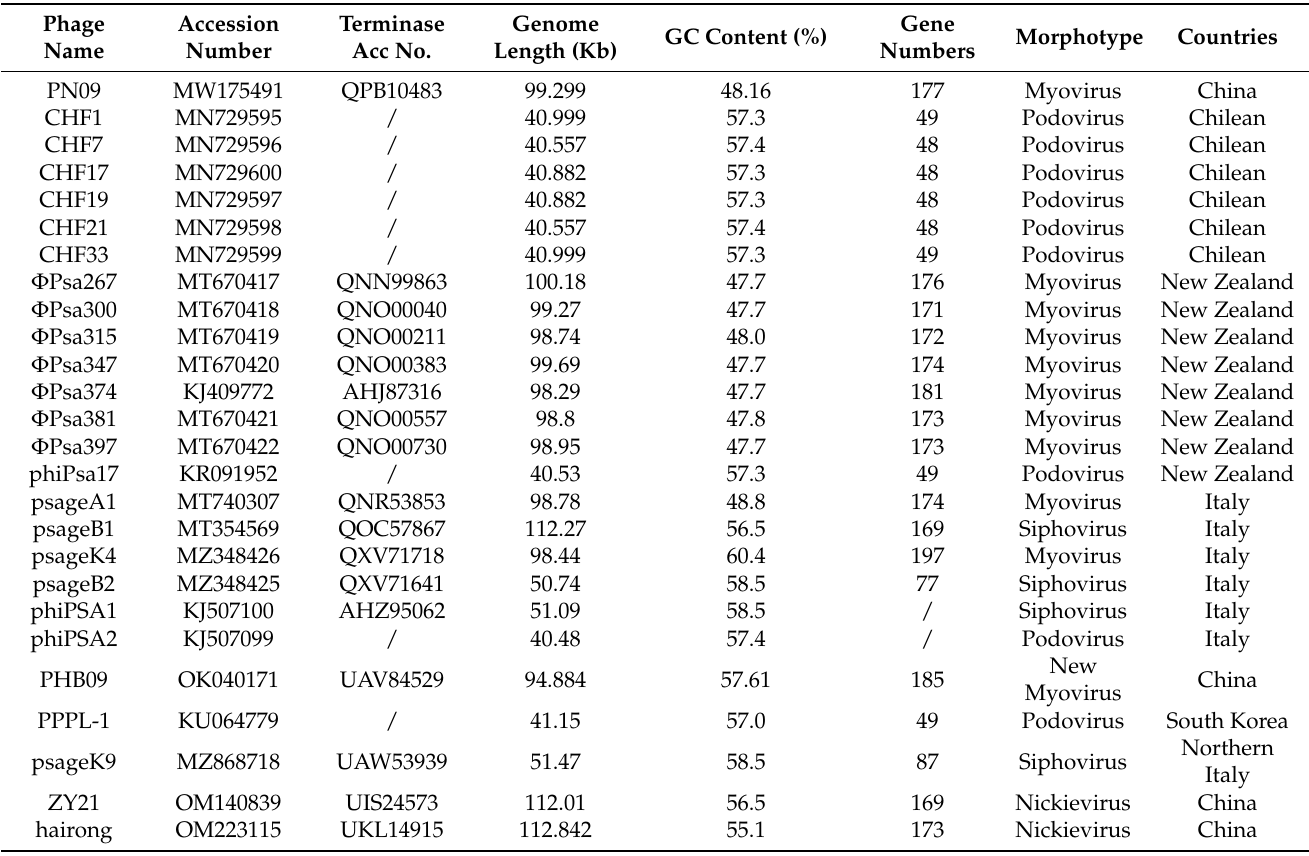
Table 4. Information of the Psa phages genomes available in the NCBI